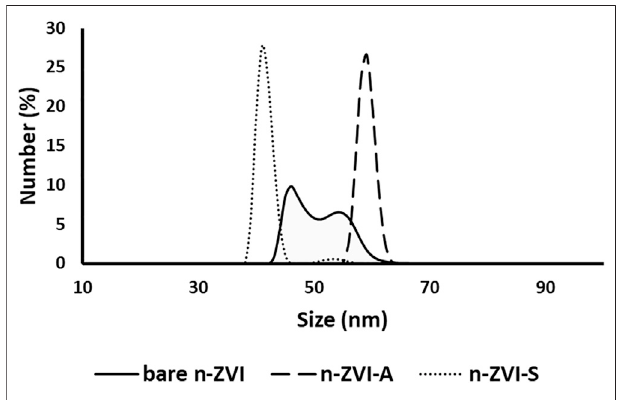
FIGURE 4 | Average particle diameter size distribution of nZVI particles.